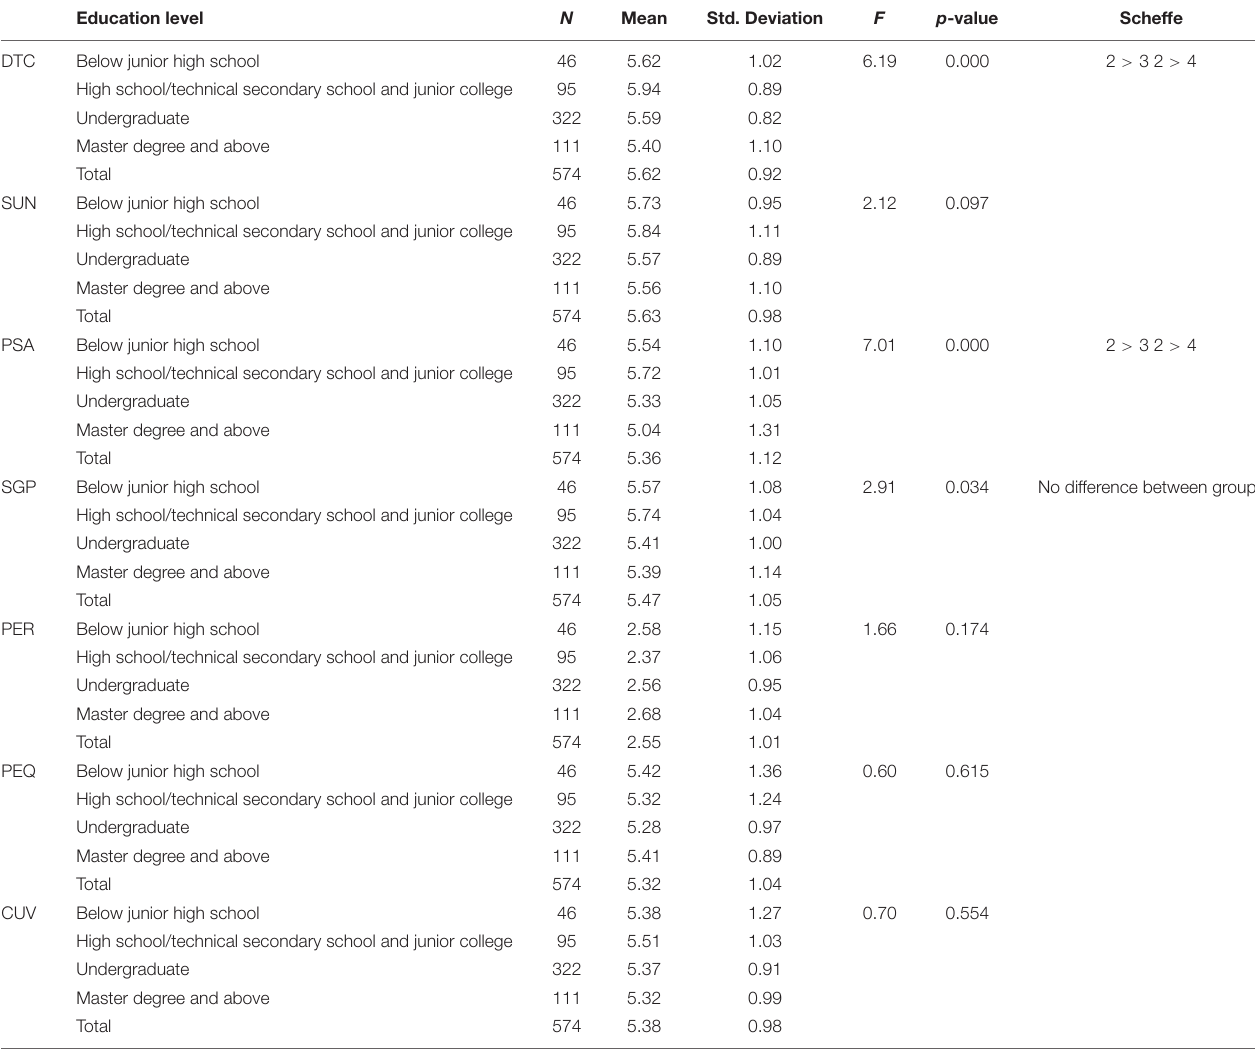
TABLE 10 | Analysis of variance by education